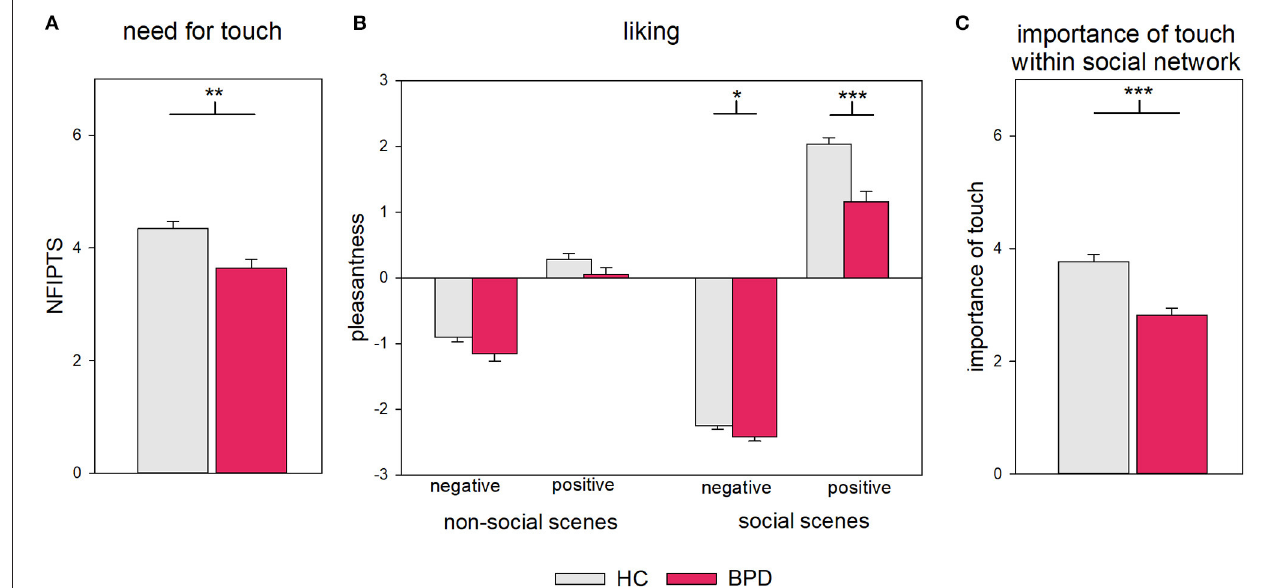
FIGURE 2 | (A) Need for touch, (B) liking of touch, and (C) importance of touch within social network in HC and BPD. Error bars represent 1 SE. * P < 0.05. ** P > 0.01. *** P < 0.001.